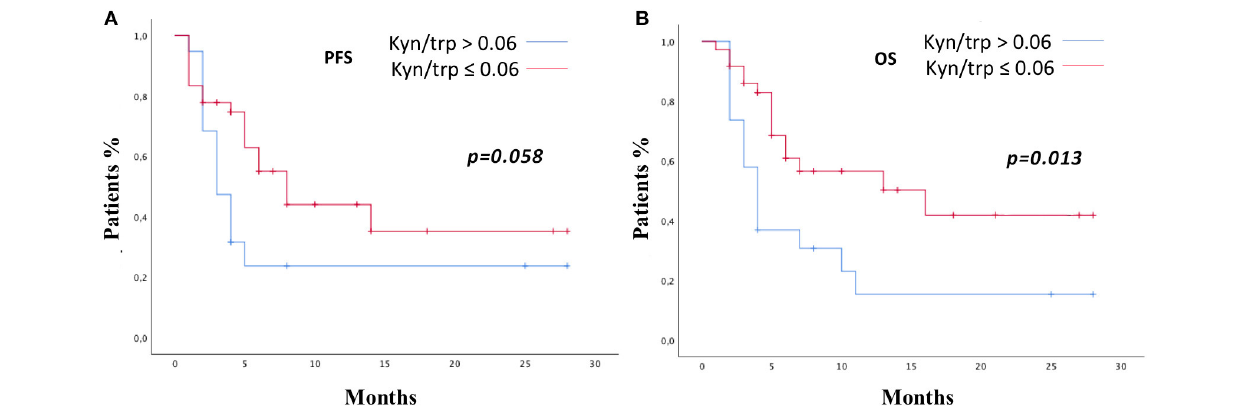
FIGURE 3 | PFS (A) and OS (B) in the study population according to kyn/trp ratio > 0.06 or ≤ 0.06 were addressed by the Kaplan–Meier method and log-rank test. PFS, progression-free survival; OS, overall survival; kyn, kynurenine; trp, tryptophan.